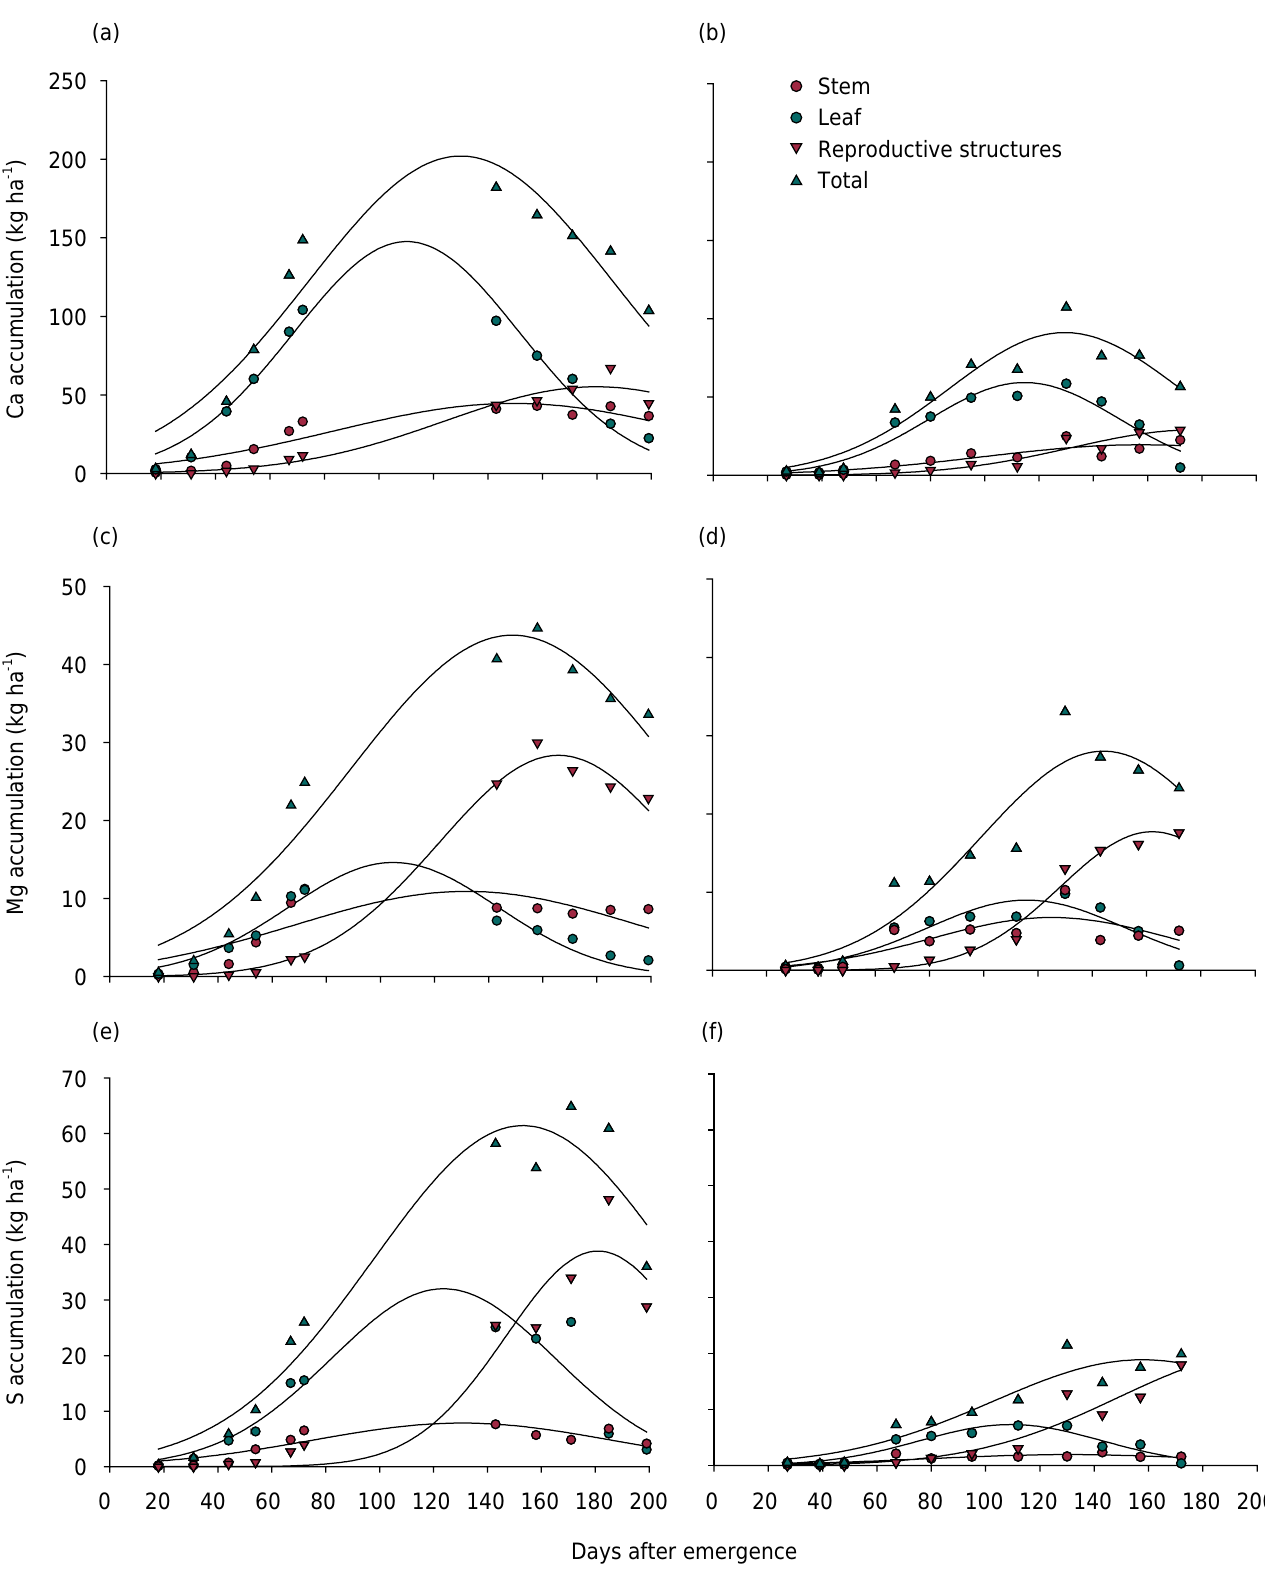
Figure 4. Accumulation of Ca, Mg, and S by cotton at the study sites in the states of Bahia (a, c, e) and Mato Grosso (b, d, f), Brazil. Results represent the average of three varieties in Bahia and two varieties in Mato